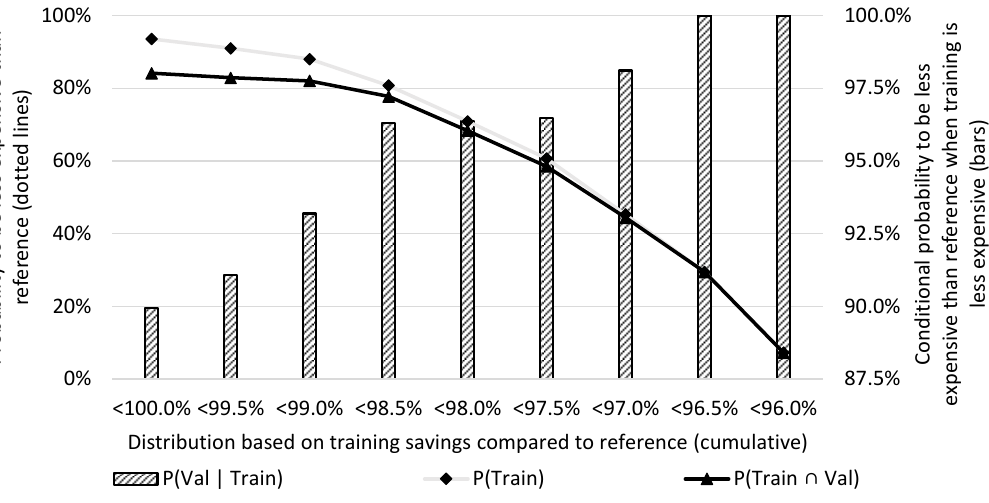
Figure 8. Probabilities of trained agents to reduce operational costs on validation dataset, depending on their training savings.